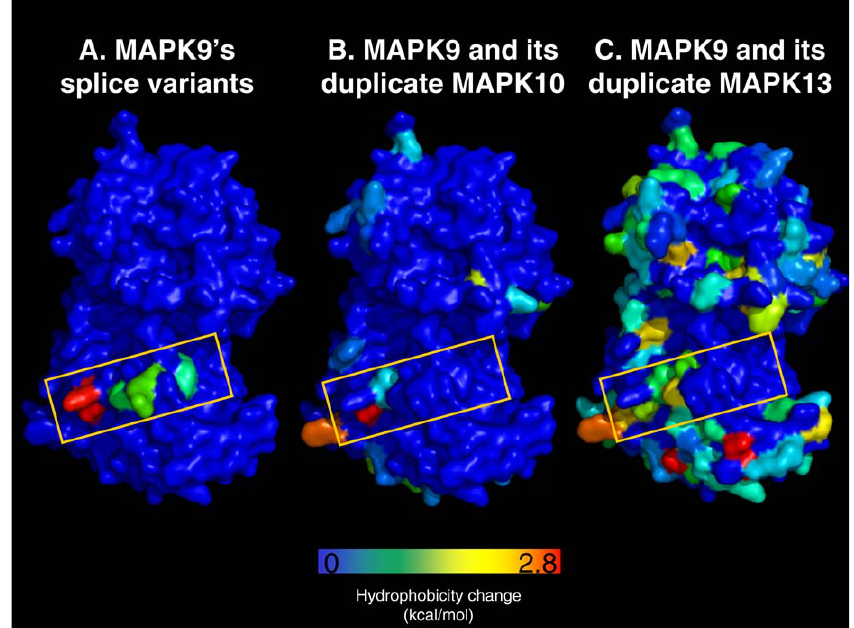
Figure 5. The 3-D Distribution of Physico–Chemical Changes in the Affected Residues of AS and GD The example of mitogen-activated protein kinase 9 (MAPK9). The example of human MAPK9 illustrates how differences between AS and GD in the distribution of sequence changes result in different distributions of physico–chemical properties across the 3-D structure. The original structure of MAPK9 was homology-modelled after MAPK10 and is shown in blue; the residue changes are indicated following a colour scale related to the associated difference in hydrophobicity (we use the absolute value of the difference in order to avoid too many colours; the colour scale goes from blue to red, where the latter corresponds to the largest change). For comparison purposes, the location of the AS changes in the three structures is indicated by a yellow box. As a hydrophobicity measure, we used the free energy of water to octanol transfer [77]. (A) Alternative splice isoforms of MAPK9. (B) Gene duplicates of high seq.id. (MAPK10; isoform alpha2, 84% seq.id. to MAPK9). (C) Gene duplicates of medium seq.id. (MAPK13; 46% seq.id. to MAPK9). We observe, in accordance with the results from the sequence analysis, that while AS changes are located at a very specific location, GD changes are spread all over the protein surface. As expected, the number of changes between MAPK9 and MAPK13 is the largest. Neither one of MAPK9 9 s paralogues (MAPK10 and MAPK13) shows a set of residue changes identical to that in the alternative splice